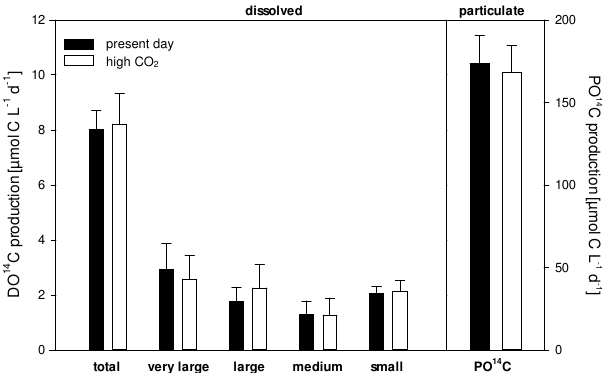
Figure 1. Dissolved (DO 14 C, left) and particulate (PO 14 C, right) primary production [µmol CL − 1 d − 1 ] of Emiliania huxleyi at present-day (filled bars) and high-CO 2 (open bars) conditions. Daily rates are additionally given for each DO 14 C size fraction. Each bar corresponds to the average ( ± standard deviation) of repli- cate samplings (sampling 1–5, n = 5) performed during the steady- state period of the